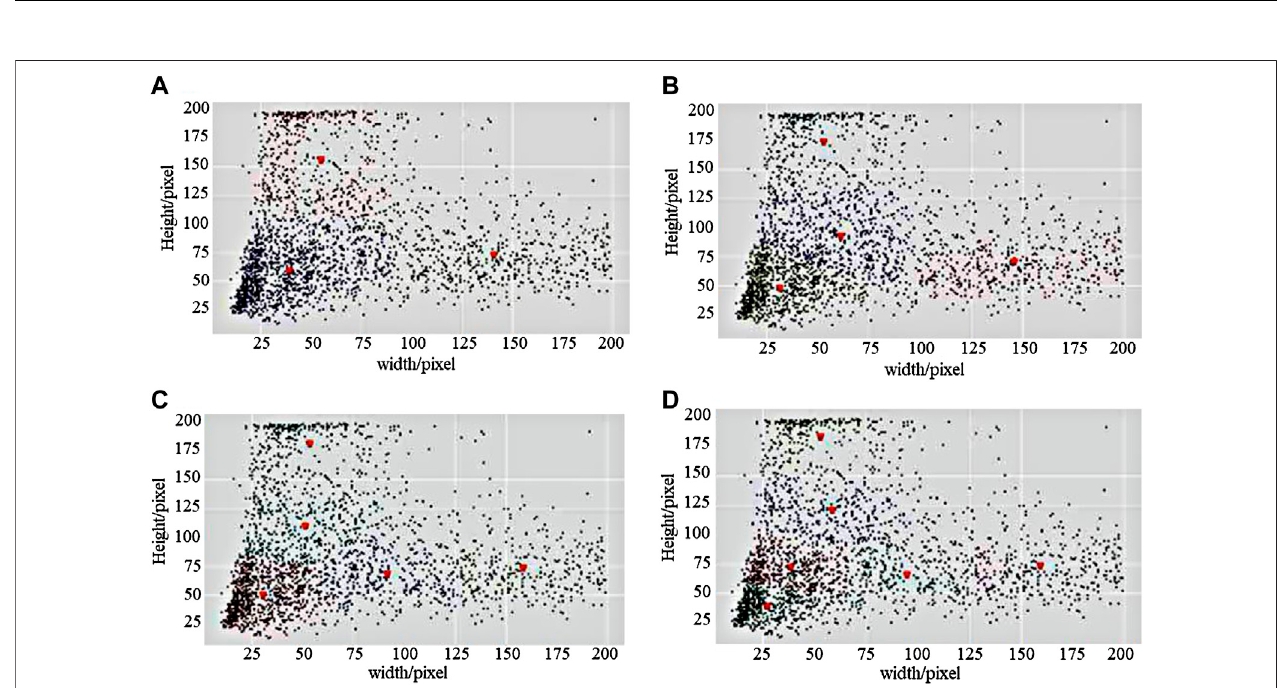
FIGURE 5 | Example of logical diagram detection.